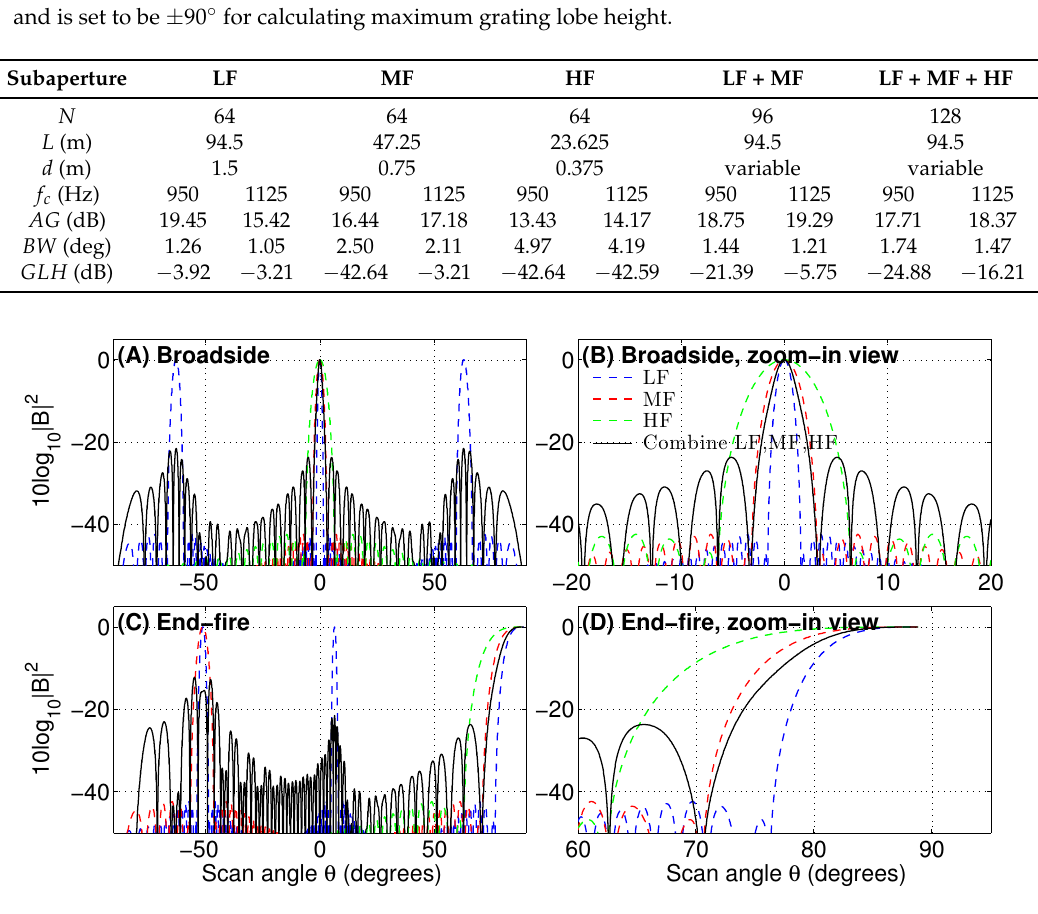
Figure 3. A comparison of the beam patterns | B ( sin θ − sin θ 0 , f ) | 2 of the conventional uniformly-spaced individual subapertures LF, MF, and HF (dashed lines) and the newly defined nonuniformly-spaced subarray combining the three subapertures (solid line) at frequency f = 1125 Hz. The incident signal is assumed to be in the direction of ( A , B ) array broadside ( θ 0 = 0) and ( C , D ) array end-fire ( θ 0 = 90 ◦ ), respectively. The subplots ( B , D ) are zoom-in views of the subplots ( A , C ) around the main